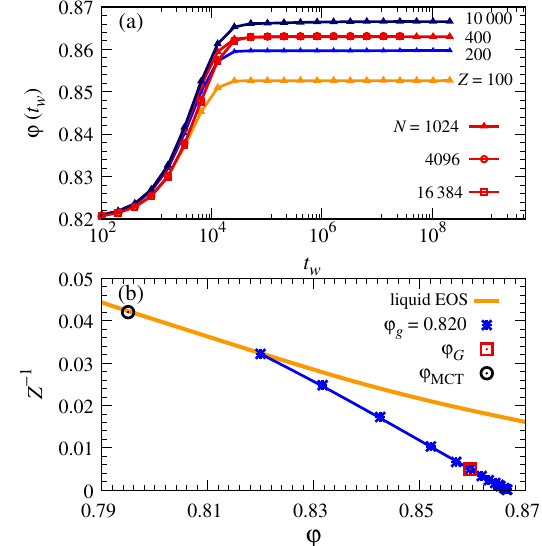
FIG. 1. (a) Waiting time evolution of the volume fraction φ after ¼ 31 to the targeted the pressure is suddenly increased from Z g value for N ¼ 1024 . For each pressure shown, a steady state value ≈ 10 4 . For Z ¼ 400 we show the of the density is reached after t w compressions obtained for larger systems with N ¼ 4096 and 16384, which exhibit no system size dependence. (b) Equation of state (EOS) for the equilibrium fluid, and glass equation of state obtained by compression of an initially equilibrated system at φ ¼ 0 . 820 . For reference, we show the location of the mode- g coupling crossover and of the avoided Gardner transition φ G